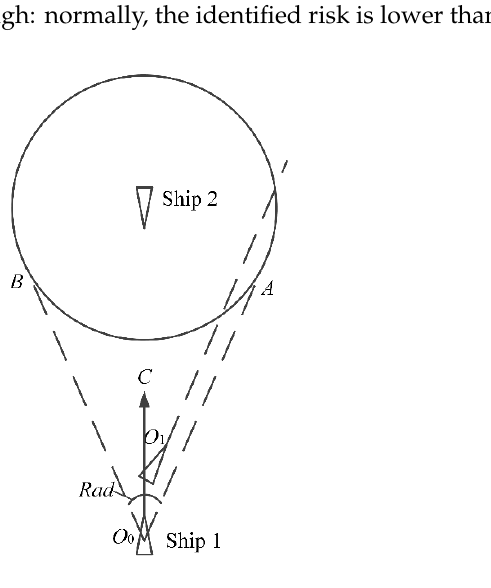
Figure 4. The illustration of possible intruding on the target ship’s domain after altering course.